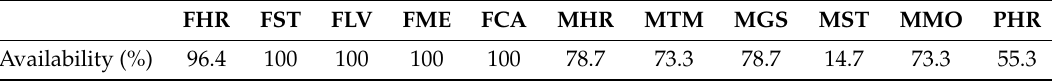
Table 2. Wearable signals’ availability. FHR : F itbit H eart R ate; FST : F itbit ST eps; FLV : F itbit L e V